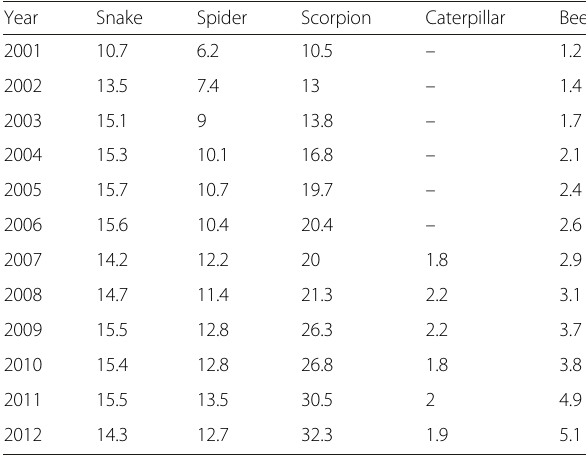
Table 3 Annual incidence of envenomations per 100,000 population in Brazil according to the venomous